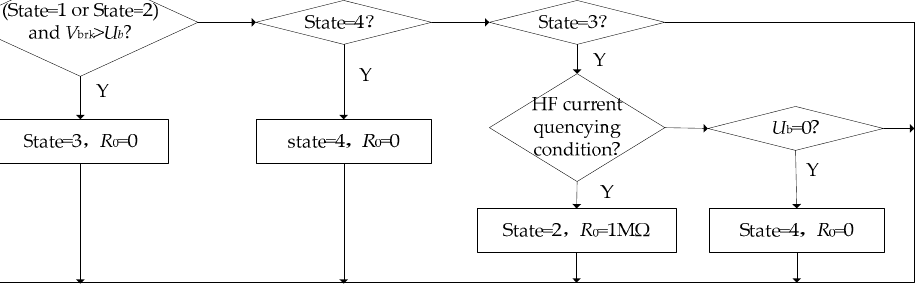
Figure 4. The program flow chart of the developed VCB model.